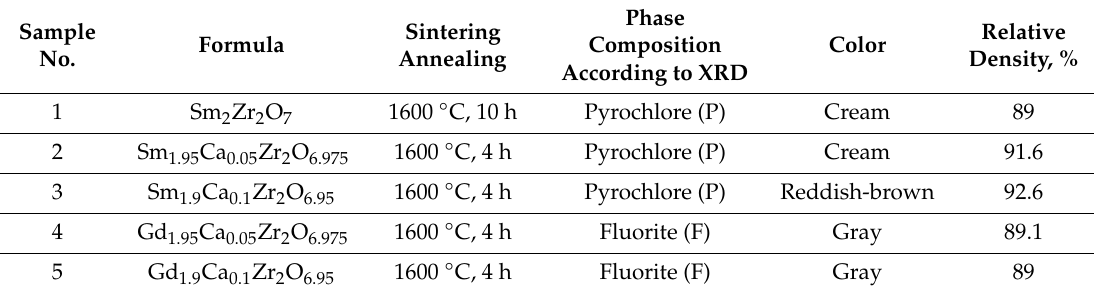
Table 1. Characteristics of the compounds under